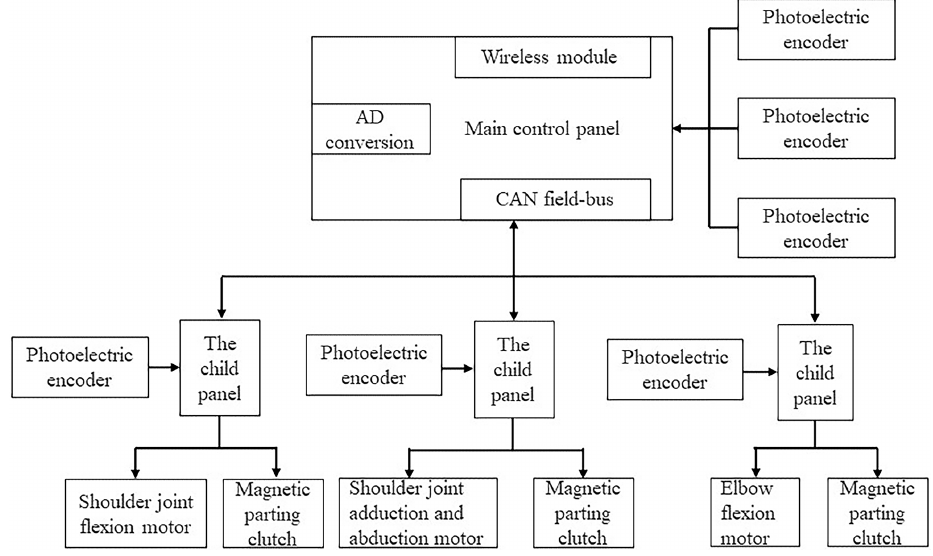
Figure 2. Electronic